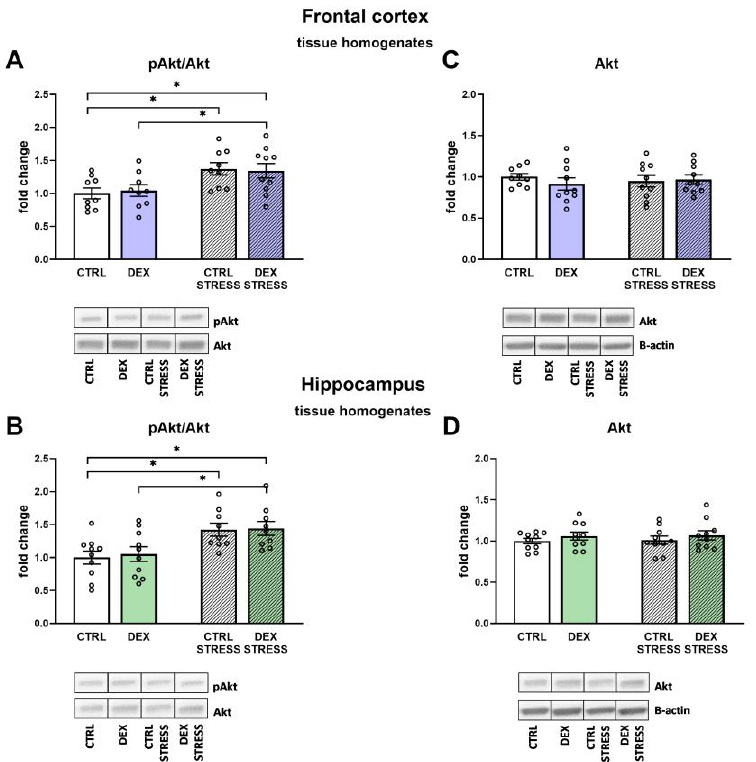
Figure 11. The effects of DEX treatment and acute stress on the levels of phospho-Akt (pAkt/Akt) and total Akt in the tissue homogenates of the frontal cortex ( A , C ) and the hippocampus ( B , D ); proteins levels were determined with Western blotting analysis; * p < 0.05, n = 9–10. The results are expressed as the average fold change ± SEM. Statistics: two-way ANOVA, followed by the Duncan test.